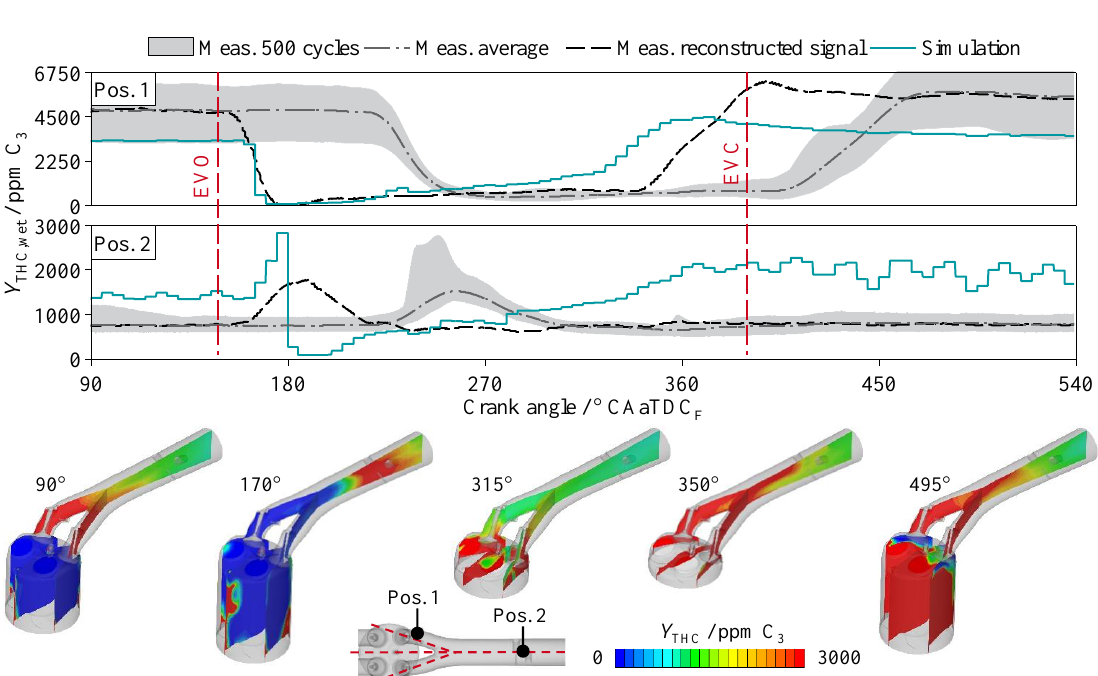
Figure 9. Top (diagram): comparison between FFID cycle-resolved measurements and simulated THC concentration in Pos. 1 and Pos. 2; FFID raw signals (all 500 measured cycles and the average) and the reconstructed curve, compared to the CFD prediction. Bottom: CFD pictures of the total-HC (THC) distribution in the combustion chamber and in the exhaust system (see the pictogram) at different crank angles. Operating point